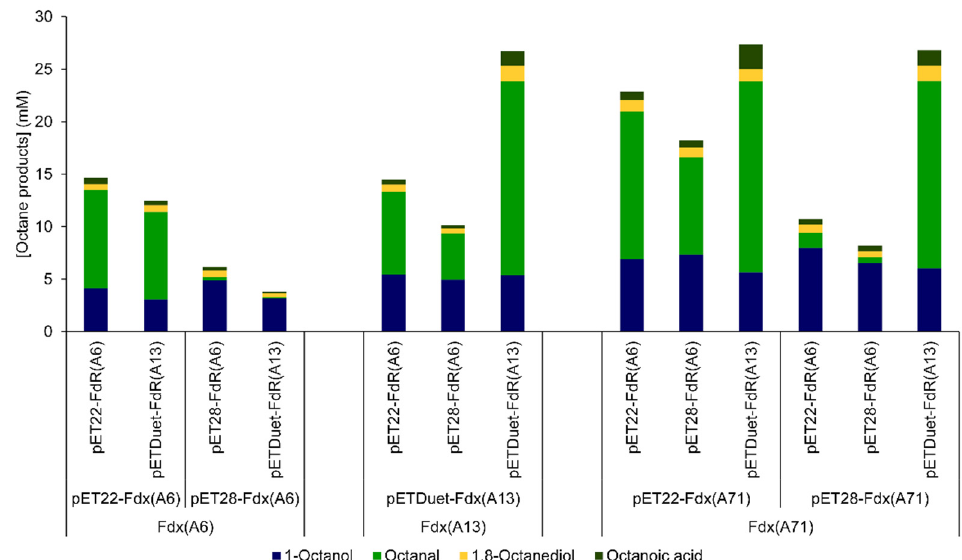
Figure 2. Hydroxylation of n -octane by CYP153A71 reconstituted with surrogate redox partners from CYP153A6 (Fdx-A6 and FdR-A6), expressed in pET22b(+) or pET28b(+), and the redox partners of CYP153A13 (Fdx-A13 and FdR-A13) expressed in pETDuet, or native Fdx (Fdx-A71) with surrogate FdRs.